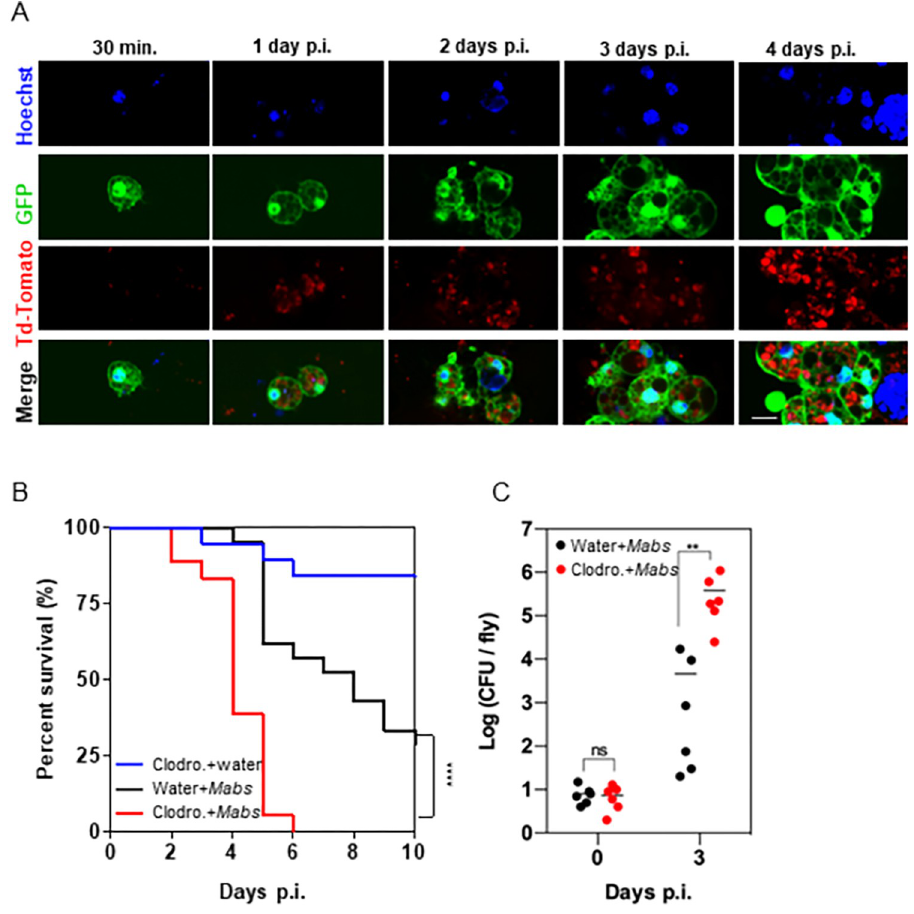
Fig 3. Phagocytes are crucial for controlling M . abscesssus infection. (A) DNA (Hoechst)-stained hemocytes (GFP) isolated from hml > eGFP flies injected with 500 CFU (Colony Forming Unit) of S- M . abscessus (Td-Tomato) at 30 minutes (min.), and 1, 2, 3, and 4 days post-infection (days p.i). Scale bar represents 5 μ m. (B) Survival curves of w 1118 flies injected with water or clodronate liposomes (Clodro.) and then injected with water or 10 CFU of M . abscessus ( Mabs ). (C) Bacterial load quantification on day 3 p.i. by CFU counting of w 1118 flies injected with water or clodronate liposomes (Clodro.) and injected with 10 CFU of M . abscessus ( Mabs ). Survivals were analyzed in 40–60 flies per condition using the log-rank test ( * p < 0.05; **** p < 0.0001) (B and D). Bacterial loads were individually quantified from 6 flies per condition. Each point represents the CFU number of one fly, and the horizontal traits represent the mean per condition. Data were analyzed using two-way ANOVA statistical tests. Asterisks represent p-values * p = 0.01, ** p = 0.005 (C and